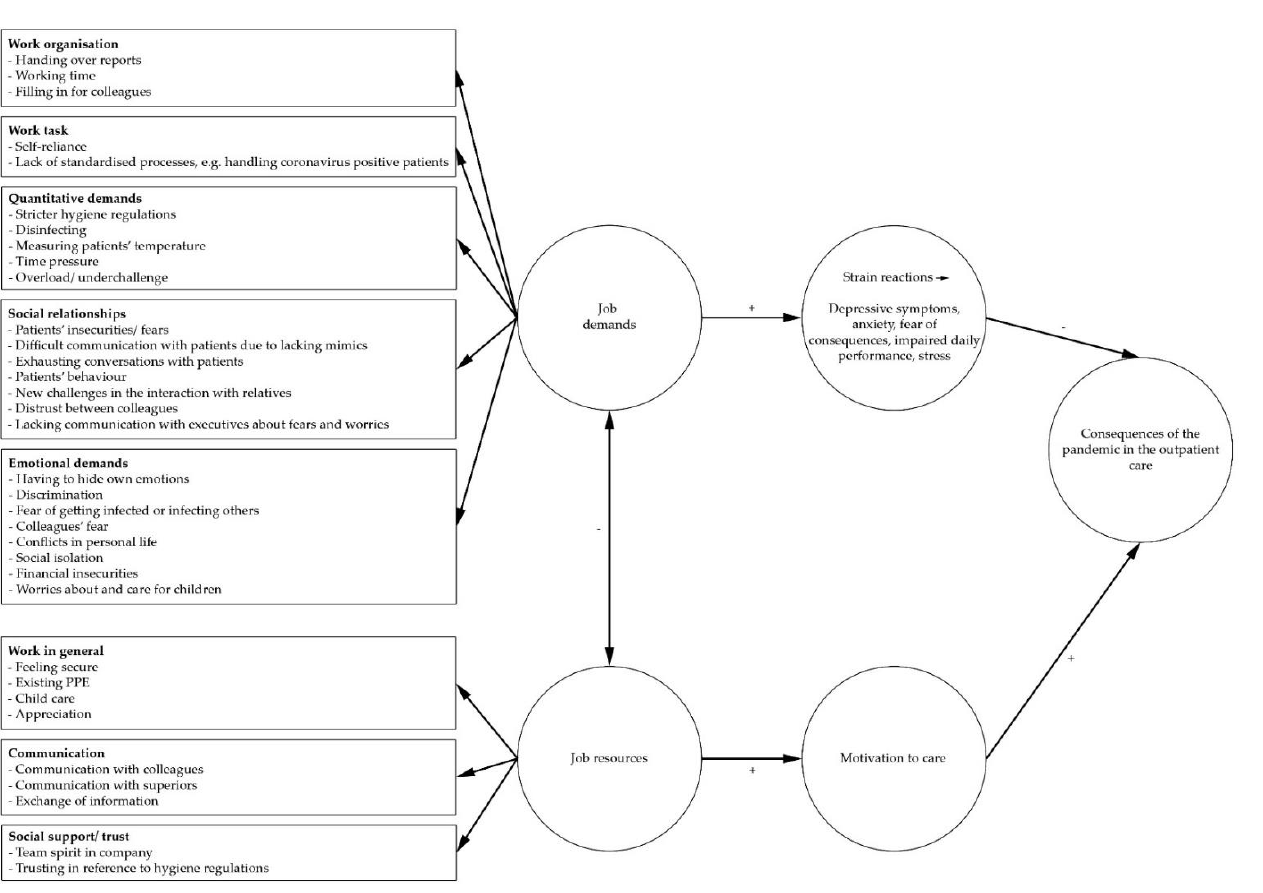
Figure 1. The Job Demands-Resources model, own depiction (following [16]).